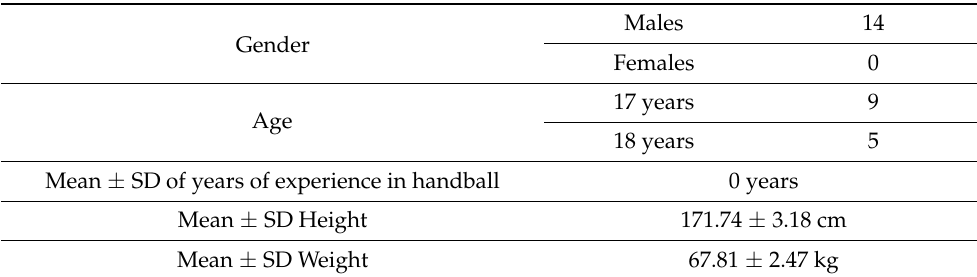
Table 1. Demographic and anthropometric characteristics of participants.